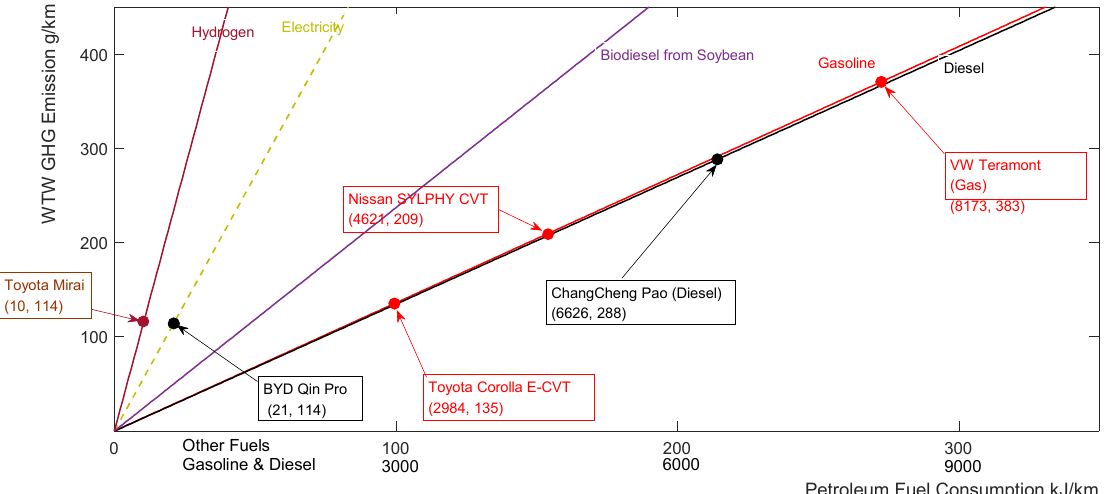
Figure 2. WTW analysis of fuel selections and vehicle visualization based on data from 2020. In Figure 2, there are two labels in the horizontal coordinate: the label with 3000/6000/9000 is used for gasoline and diesel fuel; the other labels (with 100/200/300 tricks) indicate hydrogen and electricity. The slope of these lines represents the depend- ency on petroleum fuel. A lower slope represents more dependency on petroleum fuel.